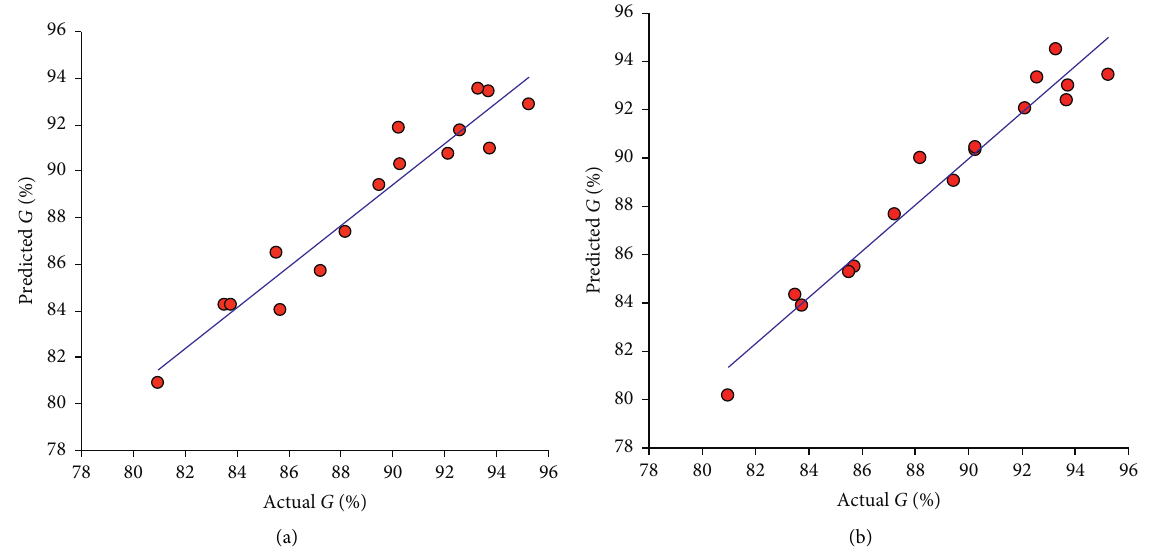
Figure 5: Predicted and actual values of G using (a) ANN and (b) NLR.